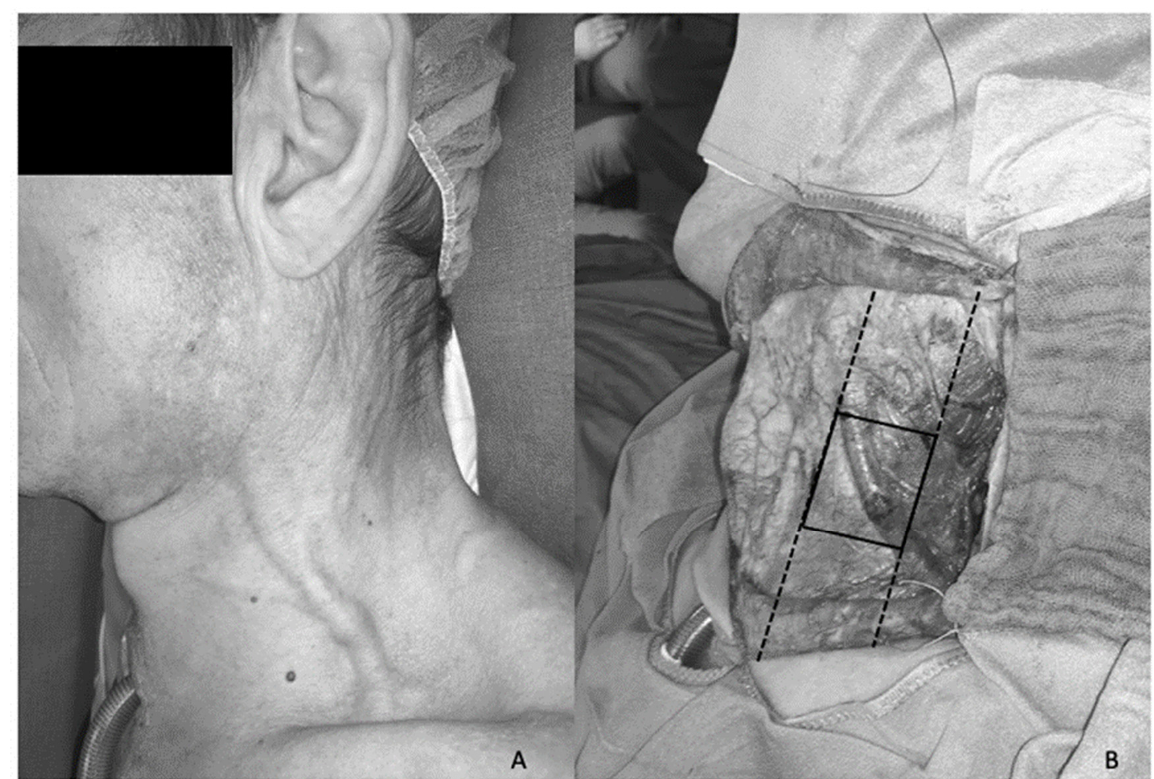
Figure 1. External Jugular Vein. ( A ) Preoperative image of the external jugular vein and ( B ) intraoperative exposure of the vein after raising of the subplatysmal flaps. The dotted lines show the anterior and posterior border of the sternocleidomastoid muscle, and the quadrangle shows the area of resection.